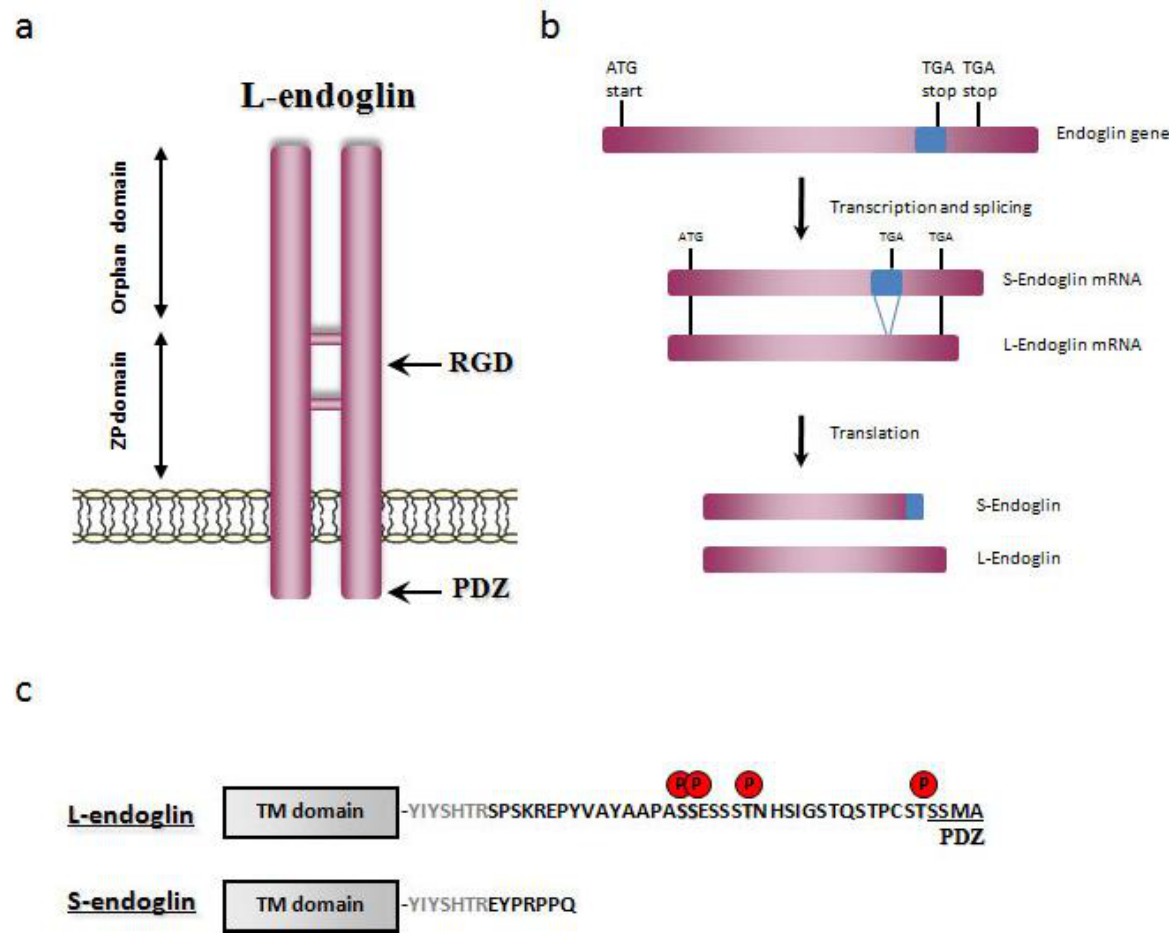
FIGURE 1 . Endoglin structure and isoforms. (a) Schematic representation of endoglin structure. The location of the integrin-binding RGD motif and PDZ-binding motif are indicated. (b) Diagram representing the alternate splicing mechanism originating L- and S-endoglin. The intron located between exons 14 and 15 (in blue), which contains a TAG stop codon, is transcribed into the S-endoglin mRNA, but is spliced out to yield the L-endoglin transcript. (c) Comparison of human L- and S-endoglin cytoplasmic domains. Identical amino acids are in grey. L- endoglin is phosphorylated at Ser/Thr residues by TβRII, ALK1, and ALK5. TM, transmembrane.